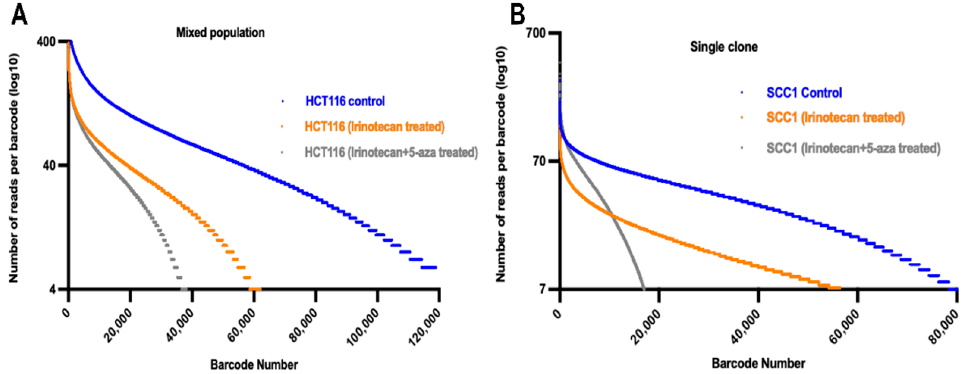
Figure 5. Effects of irinotecan alone or in combination with 5-Azacytidin on clonal size distribution. ( A ) Size distribution of clones of heterogenous cell population either untreated or treated irinotecan or irinotecan + 5-azacytidin. ( B ) Size distribution of clones of homogenous cloned cell population either untreated or treated irinotecan or irinotecan + 5-azacytidin.